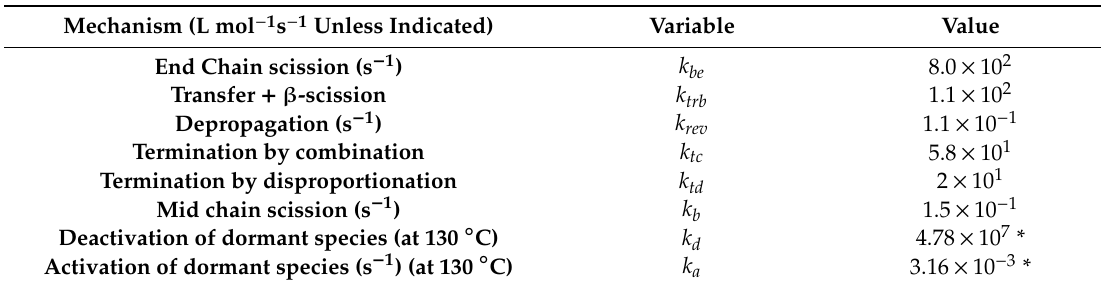
Table 5. Depolymerization kinetic constants at 350 ◦